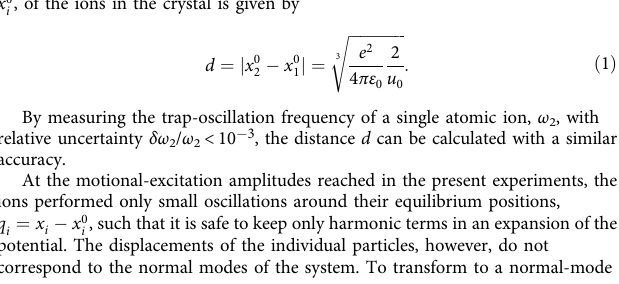
Fig. 6 State identi fi cation within a dense level structure. Stick spectrum showing the positions of the allowed P, Q and R transitions of the ð v 00 ¼ 0 Þ band of N þ A 2 Π u ð v 0 ¼ 2 Þ X 2 Σ þ originating from the rotational g 2 levels N ″ = 0 (red), 2 (magenta), 4 (orange) and 6 (blue). A subset of these states can be excluded by determining the effective detuning at speci fi c lattice wavelengths using an SP/OP experiment. The dotted, dash- dotted and dashed lines show the lattice wavelengths that enable the exclusion of rotational states N ″ = 0, N ″ ≤ 2 and N ″ ≤ 4. The detuning can be chosen either blue of the transitions (782.6, 782.1 and 781.6 nm to exclude N ″ = 0, N ″ ≤ 2 and N ″ ≤ 4 respectively) or red (787.5, 788.2 and 789.4 nm to exclude N ″ = 0, N ″ ≤ 2 and N ″ ≤ 4). By choosing the detuning opposite to the detuning of an excited state of interest, the initial and fi nal states are easily distinguishable in an SP/OP test with no available information about the hyper fi ne or Zeeman structure of either upper or lower states or the speci fi c transition